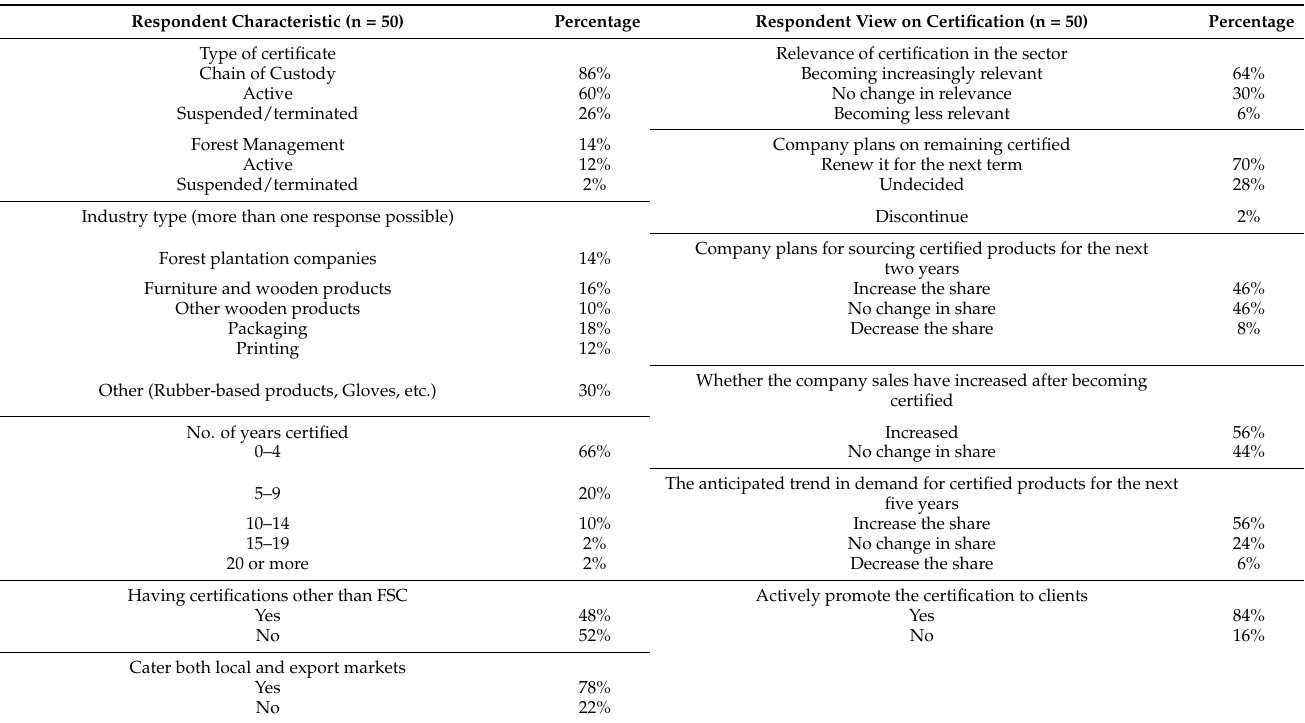
Table 2. Respondent firm characteristics and their views on FSC